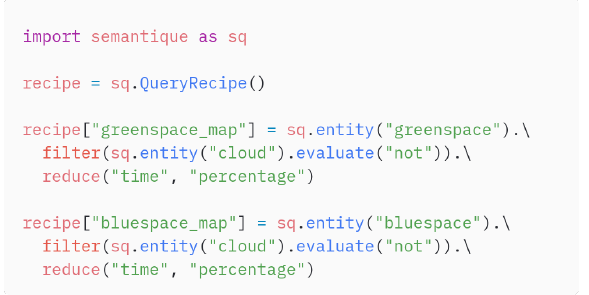
Figure 2. Code snippet for writing a query